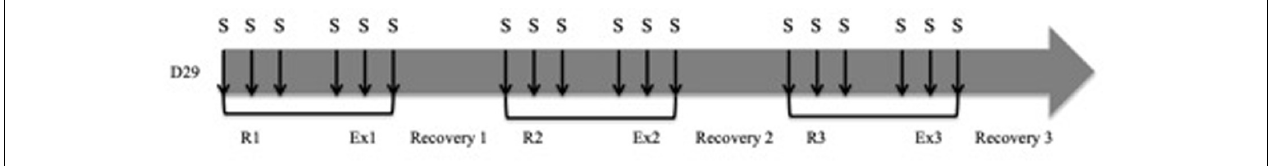
FIGURE 2 | Chronology of experimental interventions: 3 consecutives sequences (R, rest; Ex, exercise; S, tracheal stimulation).